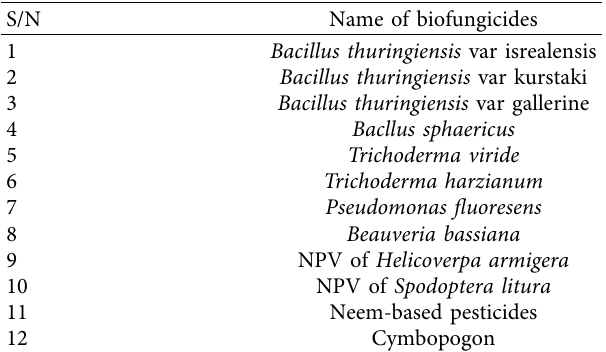
Table 5: Biopesticides registered under the Insecticides Act,